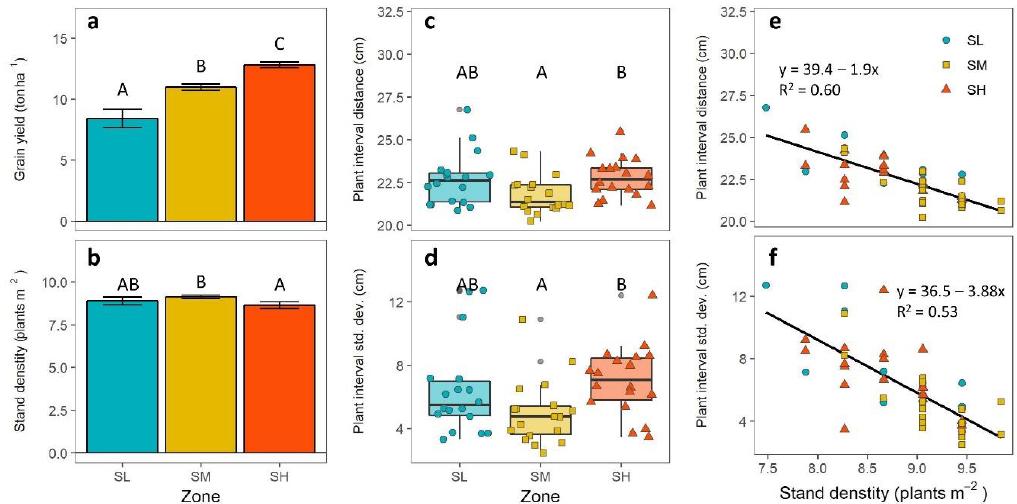
Figure 4. Grain yield ( a ) and plant stand characteristics ( b – d ) across plots in zones with stable-low (SL), stable-medium (SM), and stable-high (SH) yields. Error bars in columns indicate standard error of the mean. Treatments with same uppercase letters indicate that means are not significantly different to a Tukey mean comparison test ( p < 0.05). Fitted linear relationship of stand density and mean plant interval distance ( e ) and standard deviation ( f ).